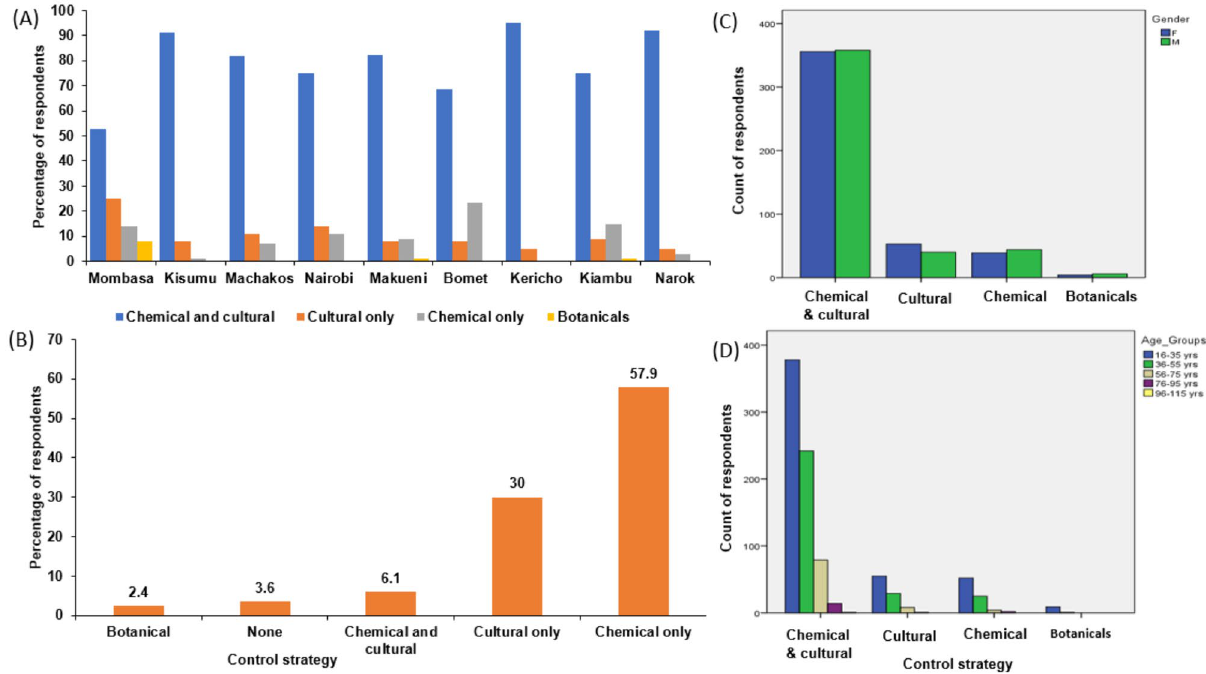
Figure 2. Control strategies recorded across different counties ( A ), the effectiveness of control and management practices ( B ), perception based on gender ( C ) and age group ( D ).